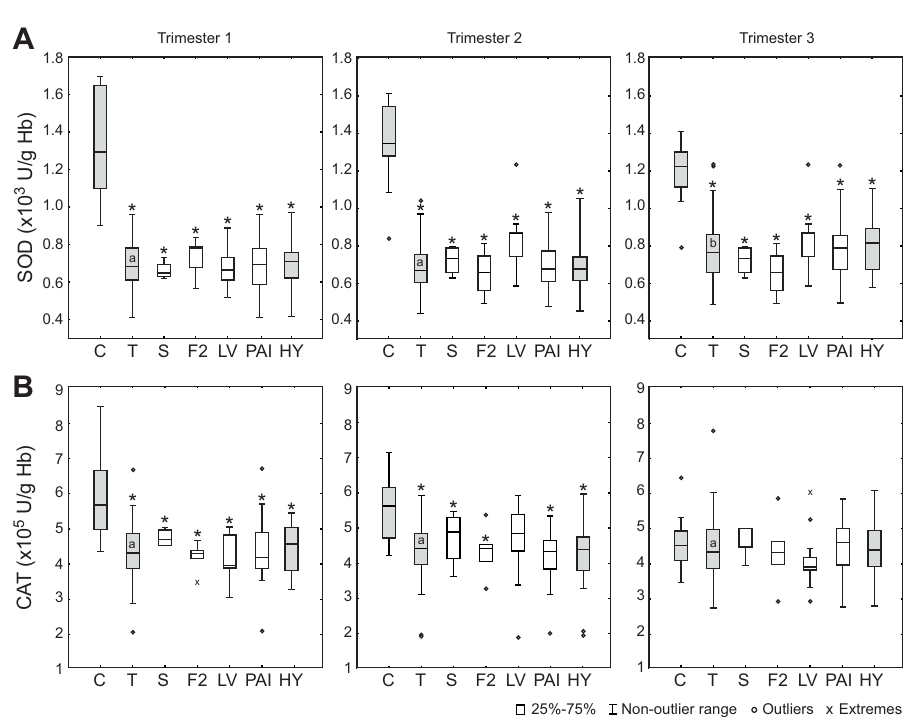
Fig 1. The activities of superoxide dismutase (SOD) and catalase (CAT) in erythrocytes in different trimesters. ( A ) SOD activity. ( B ) CAT activity. C–control (n = 10 for each trimester); T–thrombophilias (all; n = 56); S–protein S deficiency (n = 4); F2 – F2 gene mutation (n = 6); LV–Factor V Leiden mutation (n = 13); PAI– PAI -1 polymorphism (n = 31); HY–thrombophilic pregnancies burdened with hypertension (n = 20). Boxes represent the median and the 25 th and 75 th percentiles; whiskers represent the non-outlier range; circles–outliers; x—extremes. � —Statistically different compared to control (p < 0.05). Different trimesters in thrombophilic pregnancy not sharing a common letter in the box are significantly